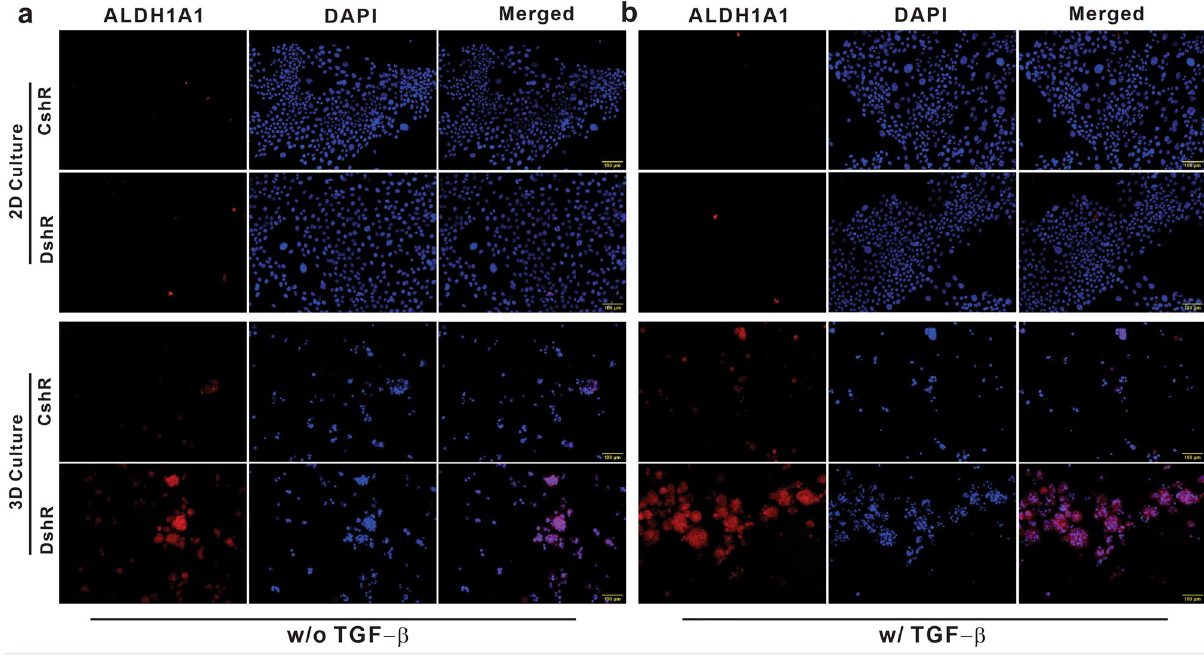
Figure 2. The effect of DEAR1 -KD on ALDH1A1 expression in 2D culture and 3D mammosphere conditions. ( a ) ALDH1A1 (red) and DAPI (blue) staining of 76N-E6 control (CshR) and DEAR1- KD clones (DshR) grown in 2D (top) or 3D (bottom) mammosphere culture in the absence of TGF-β. ( b ) ALDH1A1 staining of CshR and DshR clones grown in 2D (top) or 3D (bottom) mammosphere culture in the presence of TGF-β. Fluorescence images were taken using OLYMPUS cellSens Software. Scale bars equal 100